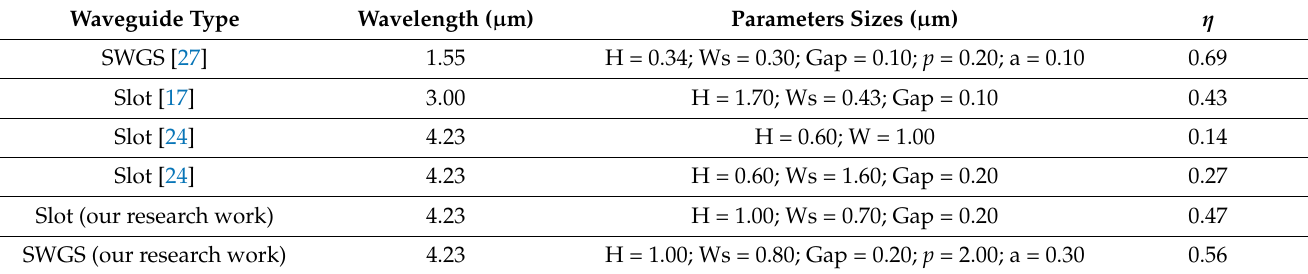
Table 2. Comparisons of various parameters under different waveguide structures.